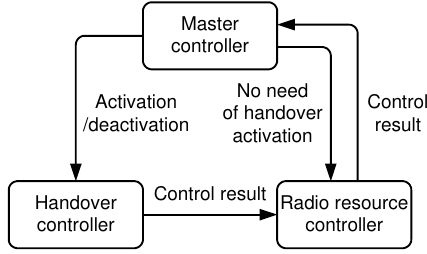
Figure 3. Interactions between the controllers of